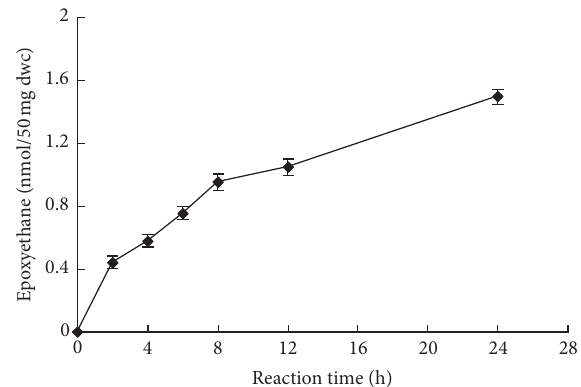
Figure 2: Time course of epoxyethane production catalyzed by whole cell suspension of Methylosinus trichosporium IMV 3011. Initial concentration of ethylene, oxygen, and nitrogen was 20%, 50%, and 30%,